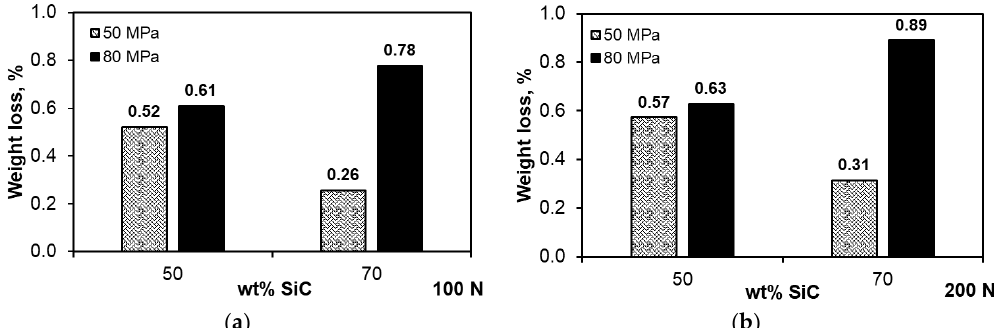
Figure 8. Variation in weight loss: (a) Load 100 N, (b) load 200 N.